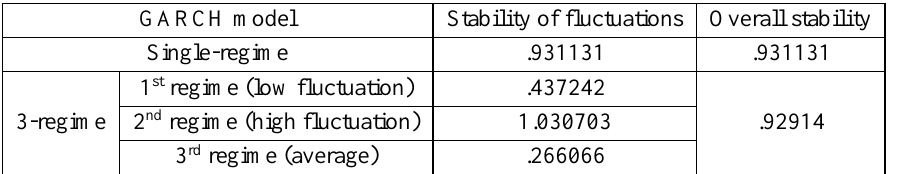
Table 6: Results of the stability of fluctuations in regime GARCH models